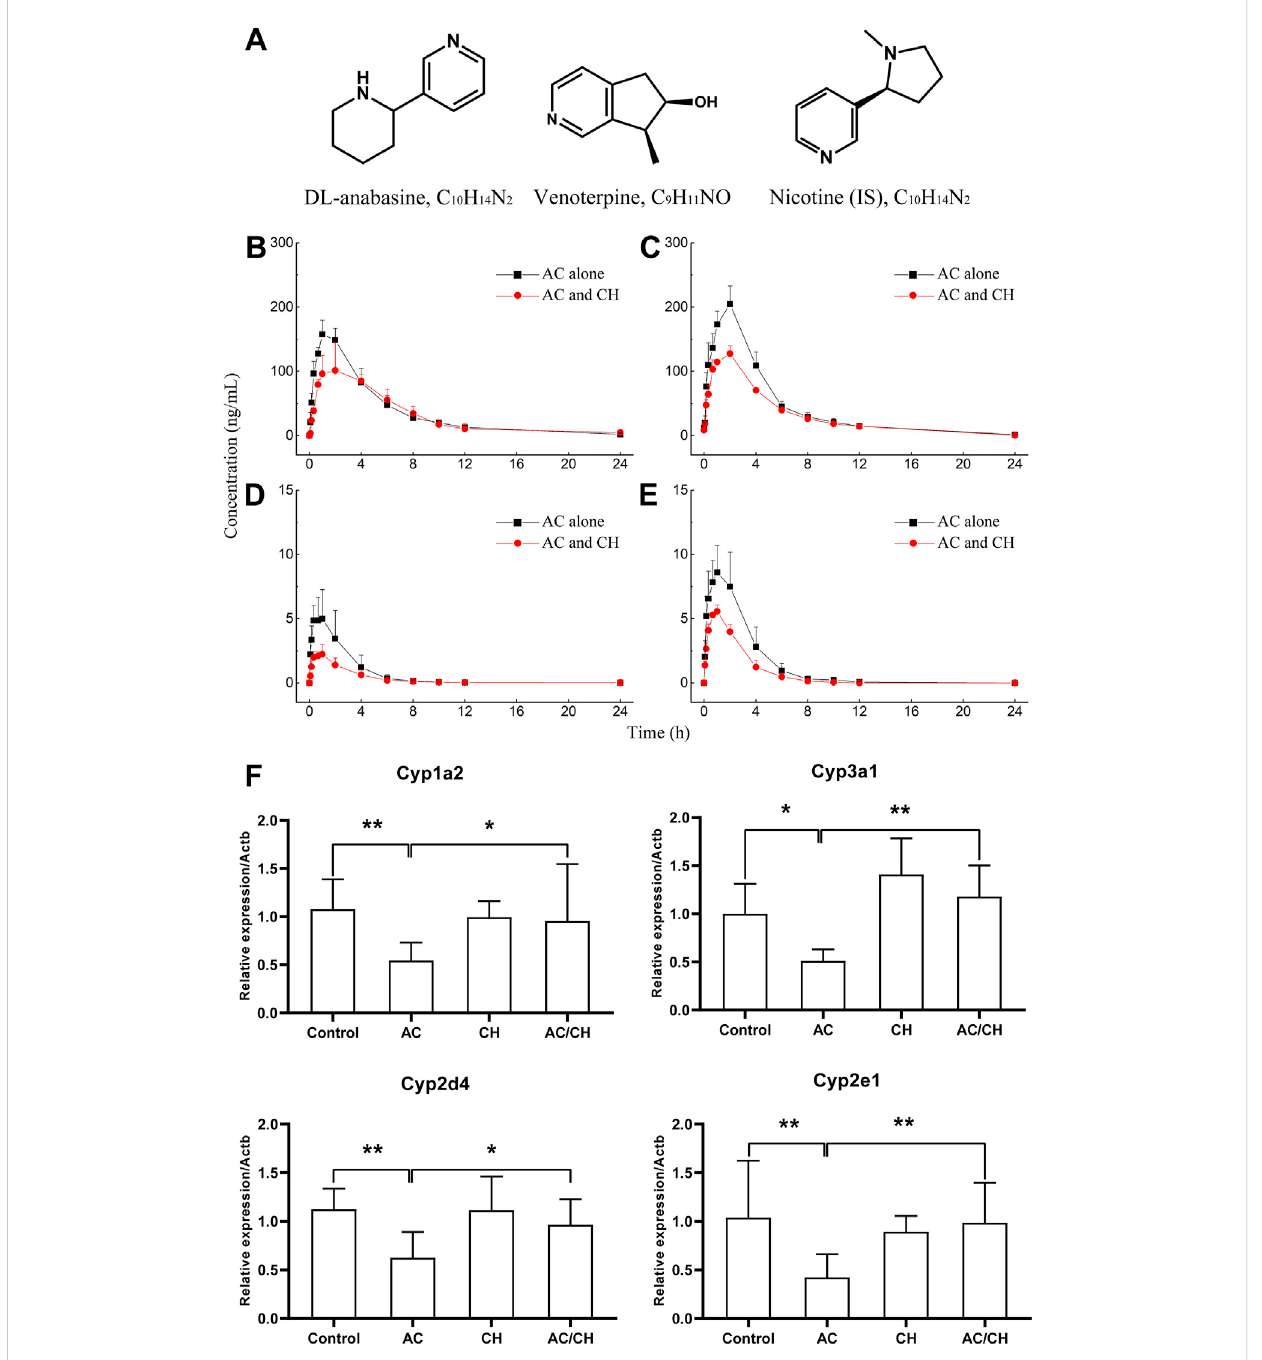
FIGURE 6 Pharmacokinetic process for the active components of Alangium chinense and the gene expression of hepatic cytochrome P450. (A) Chemical structure of DL-anabasine (ANA), venoterpin (VEN) and nicotine (IS). In a pharmacokinetic study (B – E) , male rats were treated with AC alone or co-